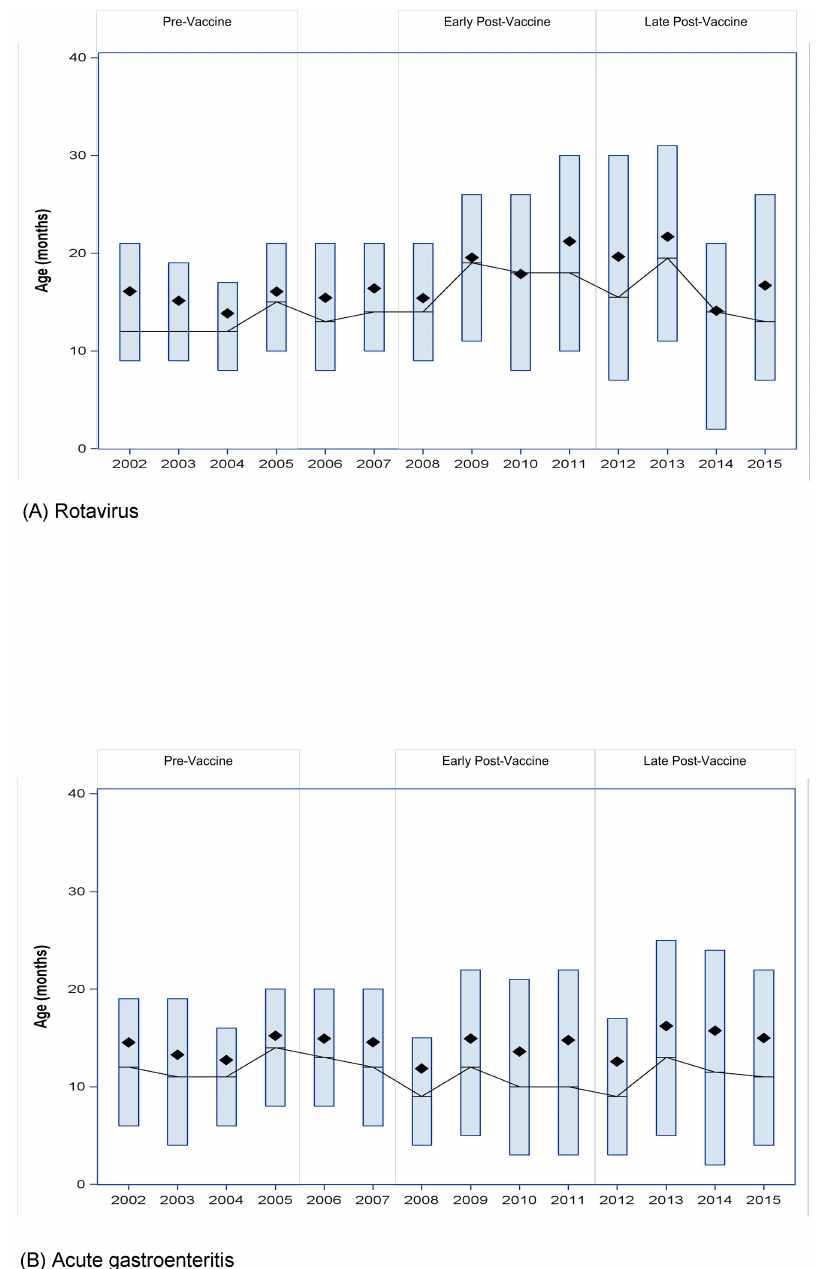
Fig 2. Age distribution for hospitalized children. Mean ( ◆ ), median (-), and inter-quartile range (box) of age of children < 60 months hospitalized for (A) rotavirus and (B) acute gastroenteritis during rotavirus seasons (Jan-Jun),